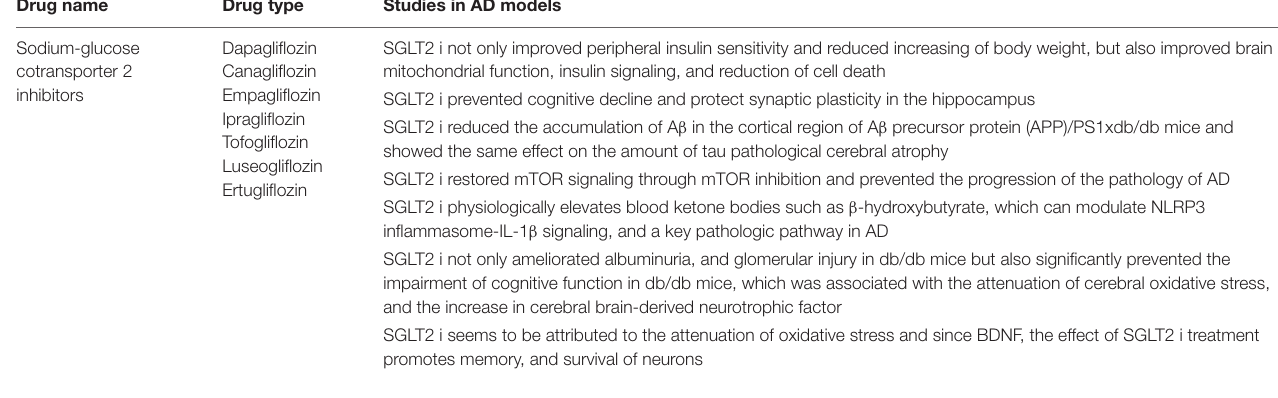
TABLE 2 | Research of SGLT2 inhibitors in AD models. Drug name